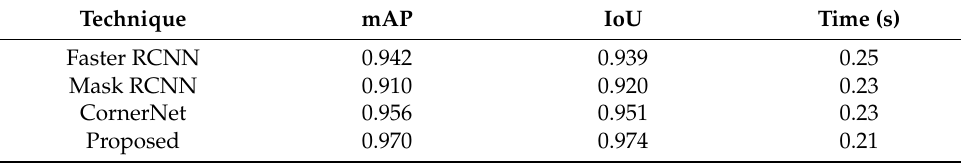
Table 3. Performance comparison of our technique with other RCNN approaches. Technique mAP IoU Time (s) Faster RCNN 0.942 0.939